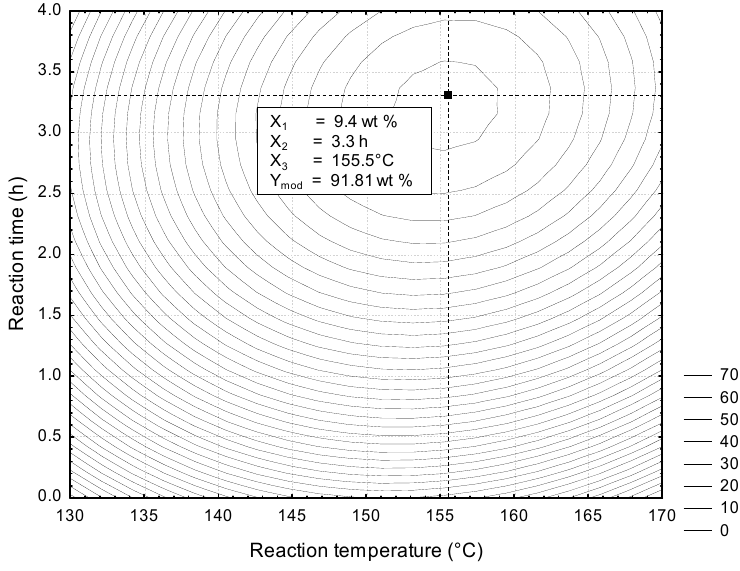
Figure 6. Graph of contour illustrating the optimum reaction temperature and reaction time for the esterification FFAs of CAPO.